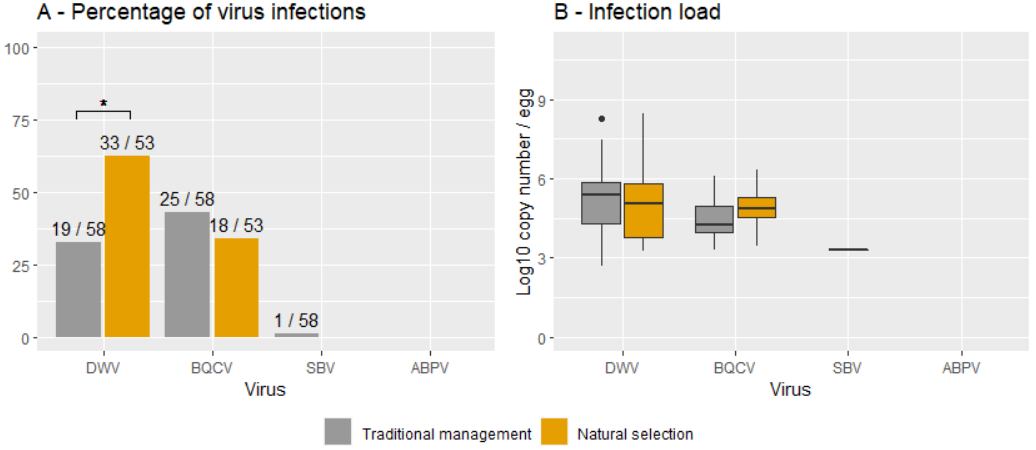
Figure 2. Percentage of viral infections ( A ) and infection loads ( B ) for naturally selected and traditionally managed colonies. Data are provided for each virus. Significant differences are indicated with *. The numbers on top of each bar represent the number of positive samples and the total sample for each group.